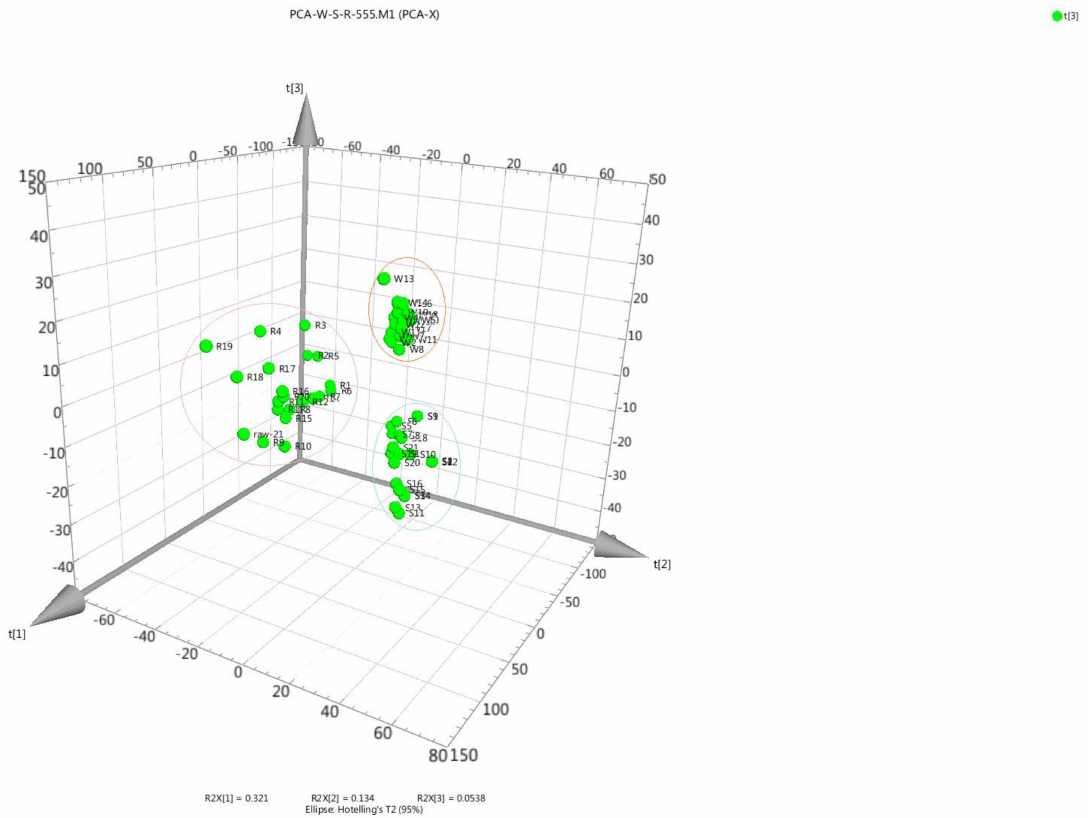
Figure 5. Three-dimensional principal component analysis (PCA) plots in 21 batches of raw RAB (RRAB), wine RAB (WRAB), and salt RAB (SRAB). Letters on the figure denote the processed type investigated: (R) RRAB, (W) WRAB, and (S)